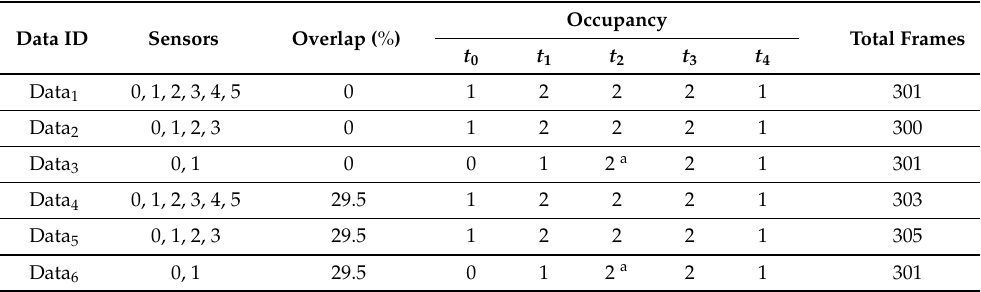
Table 2. The multi-sensor data set acquired with six sensors as represented in Figure 1. The “Sensors” and the “Occupancy” columns indicate the sensor IDs that were active and the total number of occupancy within the room. “Total frames” column shows the number of frames that were collected from each different sensor at six different data acquisition attempts.